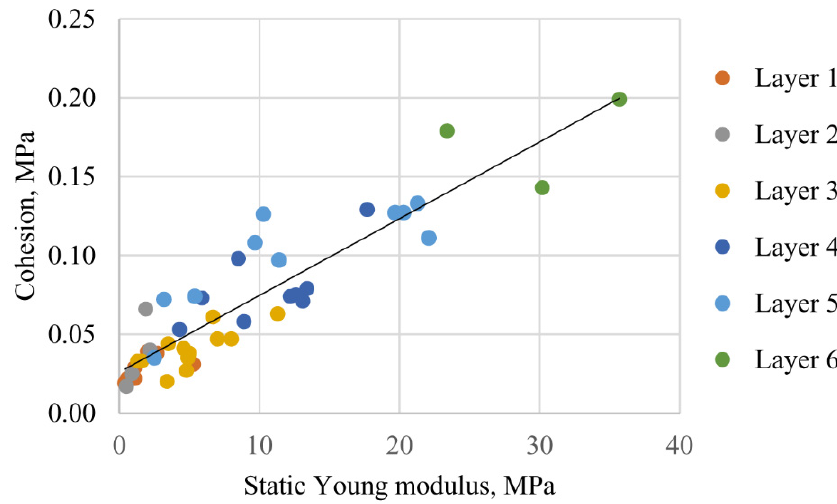
Figure 5. Reconstruction of cohesion using the static Young modulus.